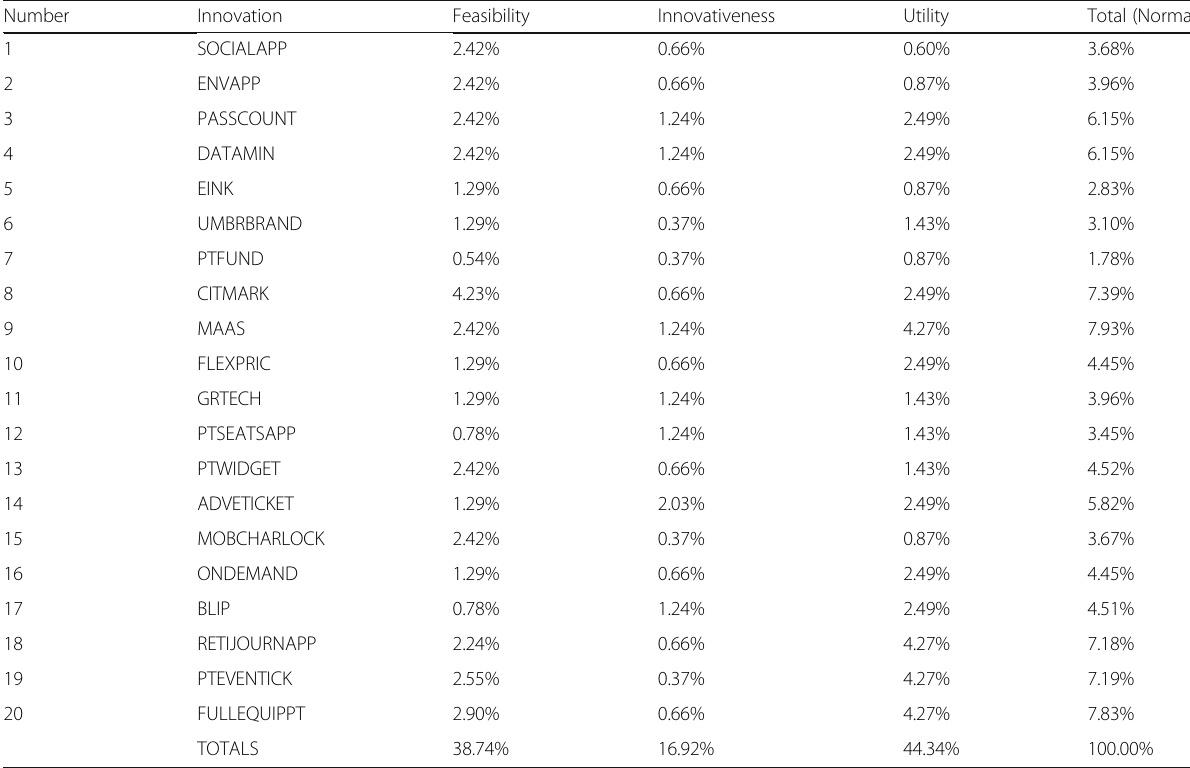
Table 8 Normals (%) per criterion and innovation